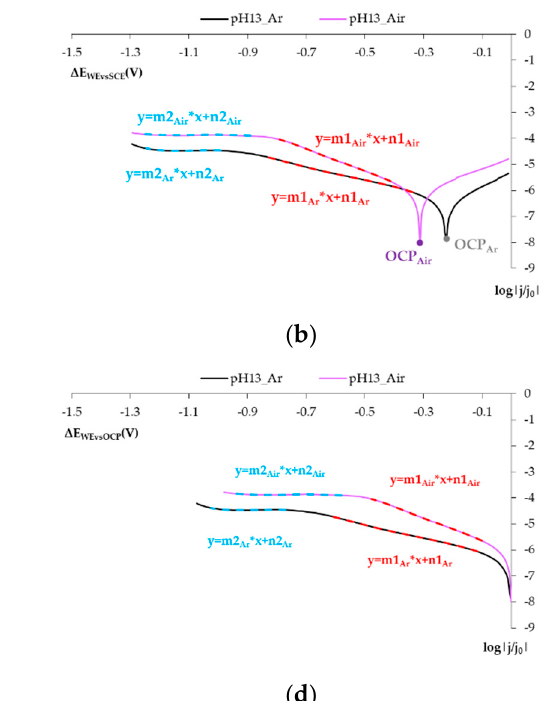
Figure 5. ( a ) Voltagrams obtained with the SS sensor under different O 2 airing conditions for the 0.1 m KOH solution. Potentials referring to the reference SCE. ( b ) Voltagram of Figure ( a ) expressed logarithmically (log|j/j 0 |), only cathodic sweeping. ( c ) Voltagrams obtained with SS sensor under different O 2 airing conditions for the 0.1 m KOH solution. Potentials referring to the corresponding OCP. Black line: Tests in an argon atmosphere. Lilac line: Tests in a synthetic air atmosphere. ( d ) Voltagram of Figure ( c ) expressed logarithmically (log|j/j 0 |), only cathodic sweeping. Black line: Tests in an argon atmosphere. Lilac line: Tests in a synthetic air atmosphere. Figure 5b,d is the logarithmic representation of the cathodic sweeping zone of the experiments indicated in Figure 5a,c. The j/j 0 logarithmic value is represented on the Y - axis, where j 0 is the reference current density of 1 A/cm 2 and j is the density obtained at each potential applied in A/cm 2 . Table 5. Values of lines 1 and 2 defined in Figure 5b,c for the airless and aired atmospheres. Line 1 Line 2 Line Range m1 n1 Line Range